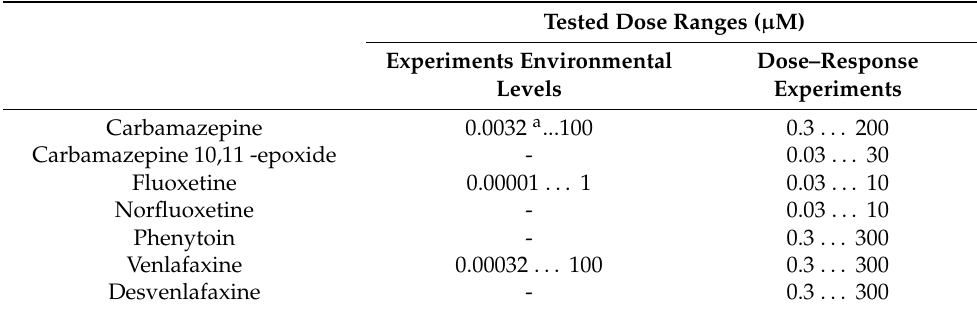
Table 1. Exposure dose range of the single-compound dose–response analysis at both experimental and environmental levels. Tested Dose Ranges ( µ M) Experiments Environmental Dose–Response Levels Experiments Carbamazepine 0.0032 a ...100 0.3 . . . 200 Carbamazepine 10,11 -epoxide - 0.03 . . .